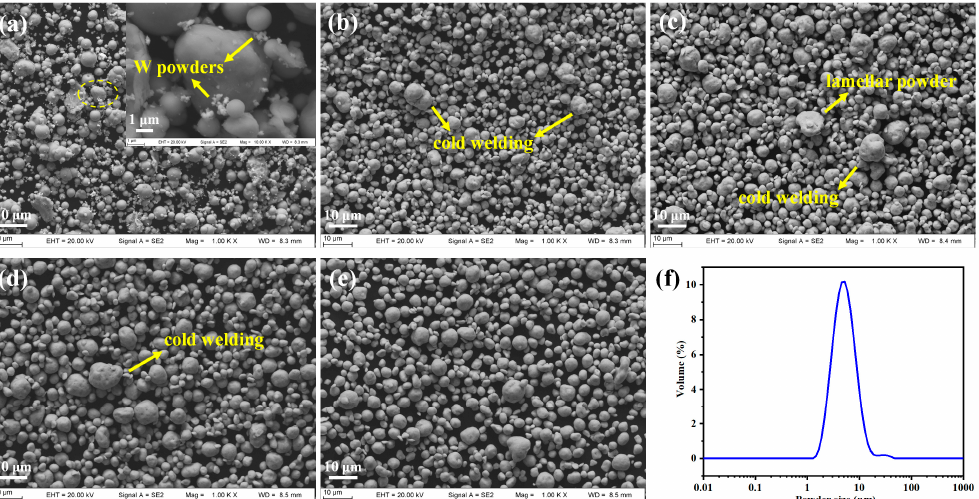
Figure 7. SEM images of powders after different milling times: ( a ) 5 min, ( b ) 16 h, ( c ) 32 h, ( d ) 48 h, and ( e ) 64 h; and ( f ) Distribution of powder size after 48 h of ball milling.